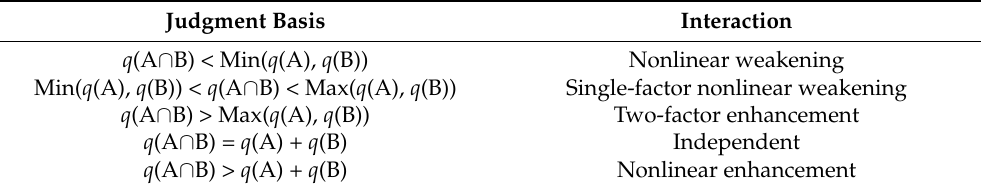
Table 3. Interaction